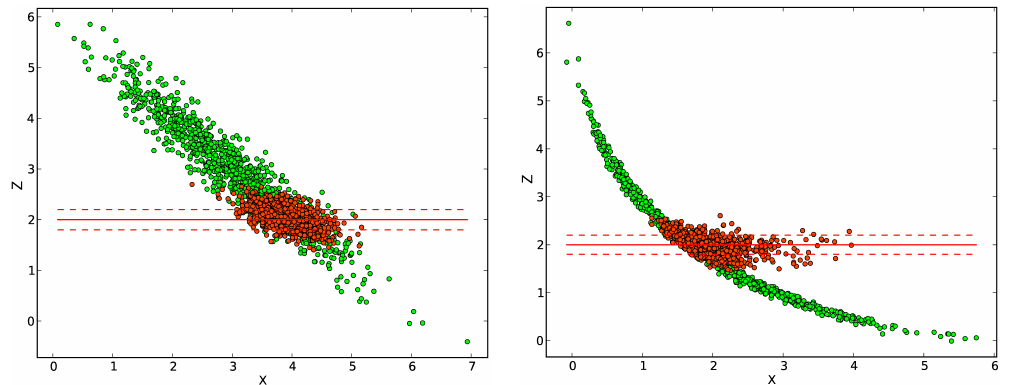
Figure 1. Illustration of EnKF analyses with joint Gaussian (left panel) and weakly non-Gaussian (right panel) prior distributions. The prior ensemble is represented by the green dots and the posterior ensemble is represented by the red dots. The variable corresponding to the z axis is observed with a value shown by the red solid line. Its uncertainty (identical in all the illustrations of Sect. 2) is assumed Gaussian with standard deviations symbolized with the red dashed lines.